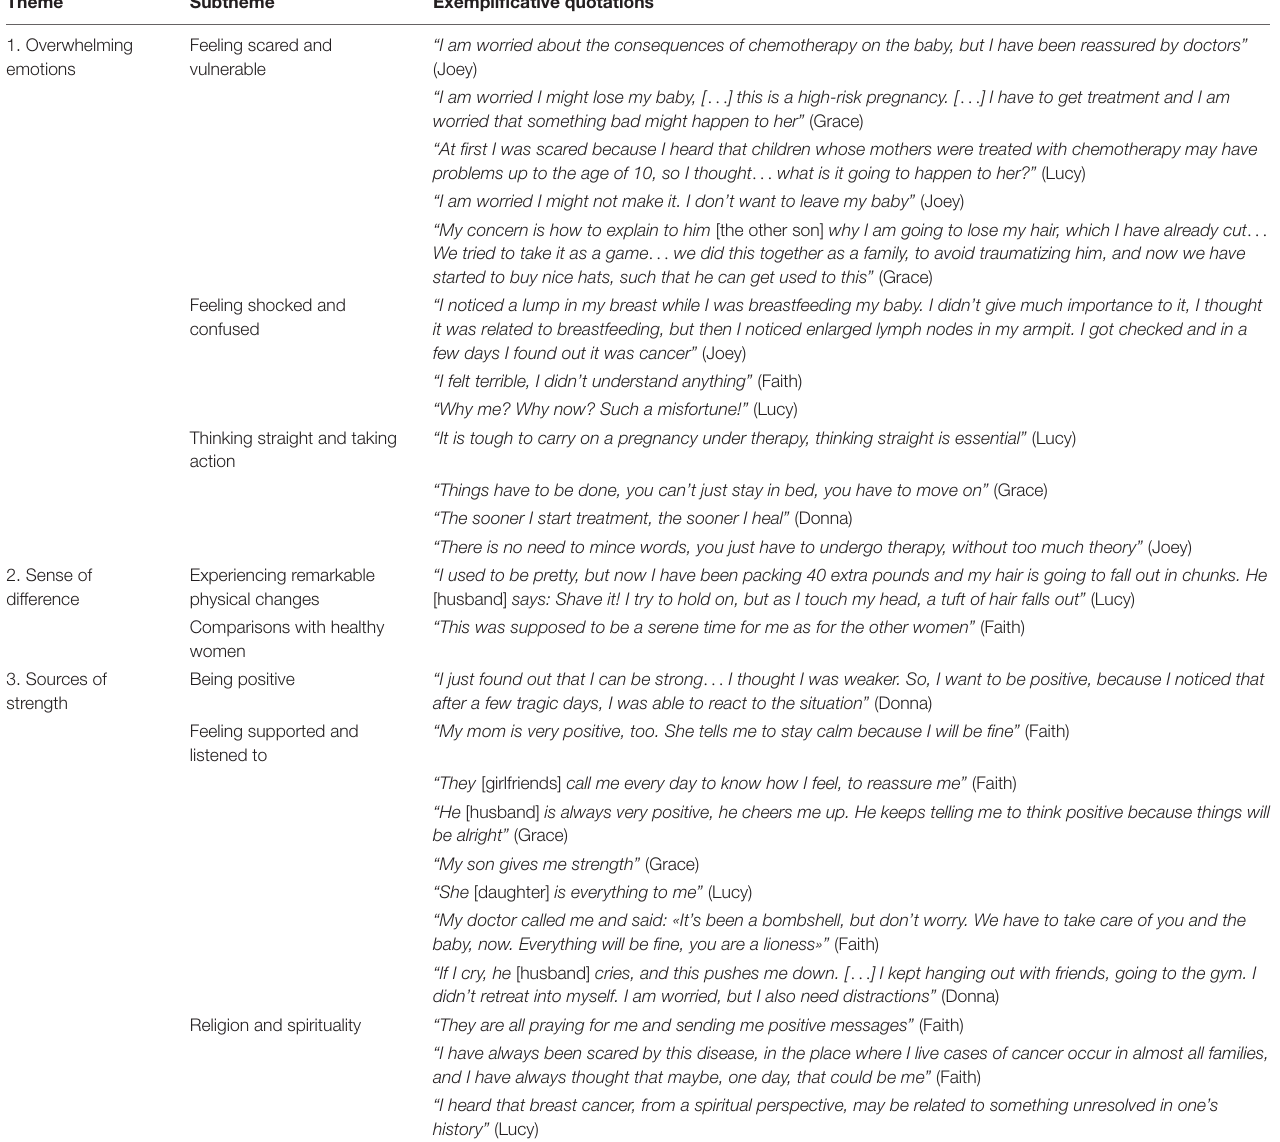
TABLE 1 | Themes, subthemes, and exemplificative